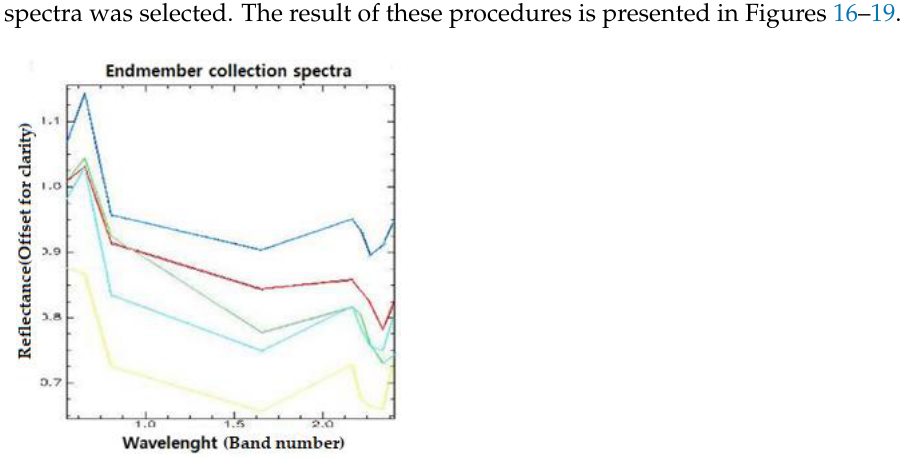
Figure 17. Chromitite-bearing pixels obtained from Anomaly B spectra and SAM in ASTER data.